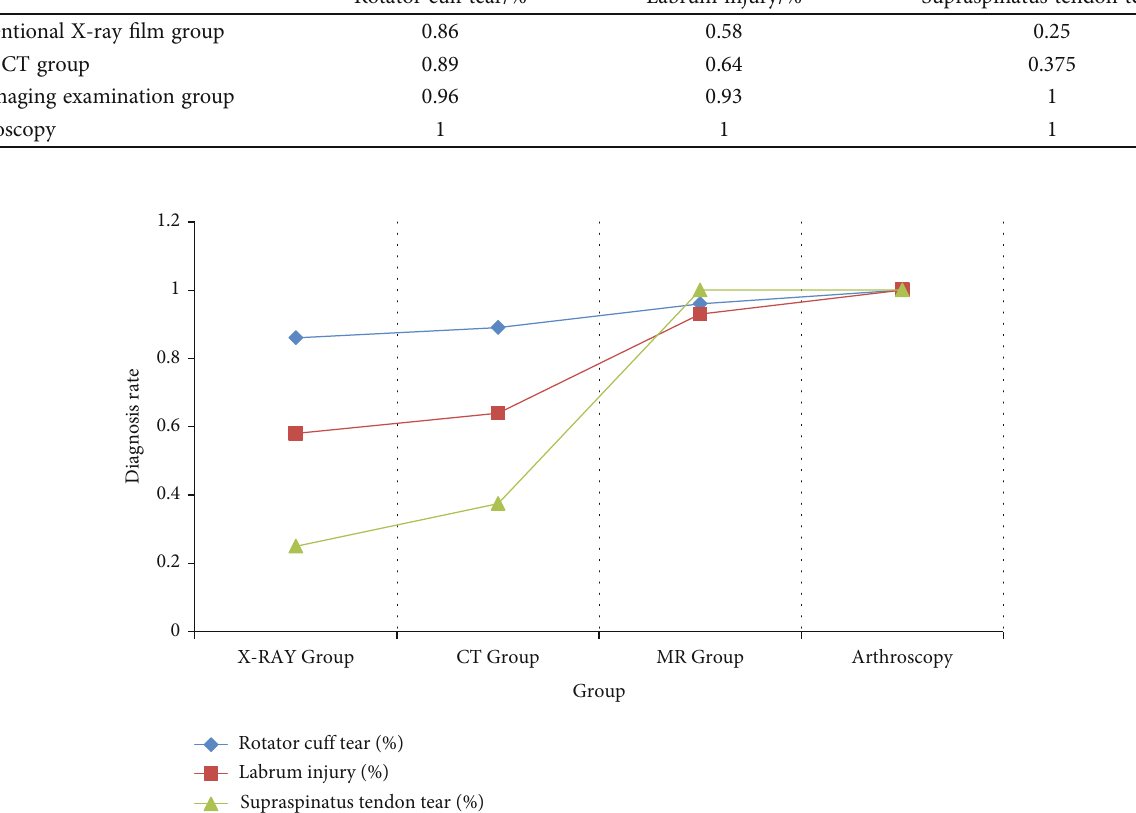
Figure 6: The proportion of shoulder joint diagnosed by three methods.